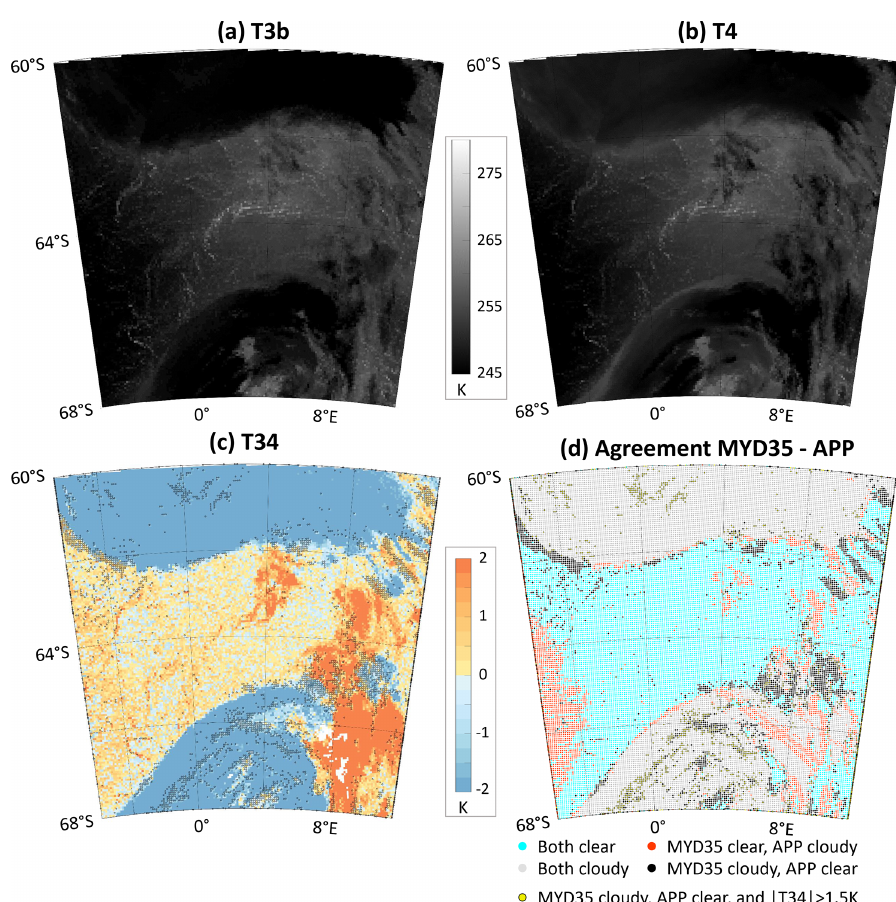
Figure A1. 10 September 2014. Infrared brightness temperatures T3b (a) and T4 (b) , on the same colour scale, and their difference T34 (c) . On these three panels, two large cloud systems are visible at the top and bottom (low T34), and smaller clouds to the right (large T34). Comparison of the cloud mask based on the APP data and the MYD35_L2 reference (d) : cyan for light pixels in both, grey for cloudy pixels in both, orange for pixels clear in the MYD35_L2 reference but detected as cloudy with APP, and black for pixels cloudy in the reference but incorrectly detected as clear. These black pixels are also indicated in panel (c) . A yellow core highlights these incorrect black pixels where the absolute value of T34 is larger than 1.5K, i.e. that are correctly detected as cloudy when the threshold on T34 is lowered from 2 to